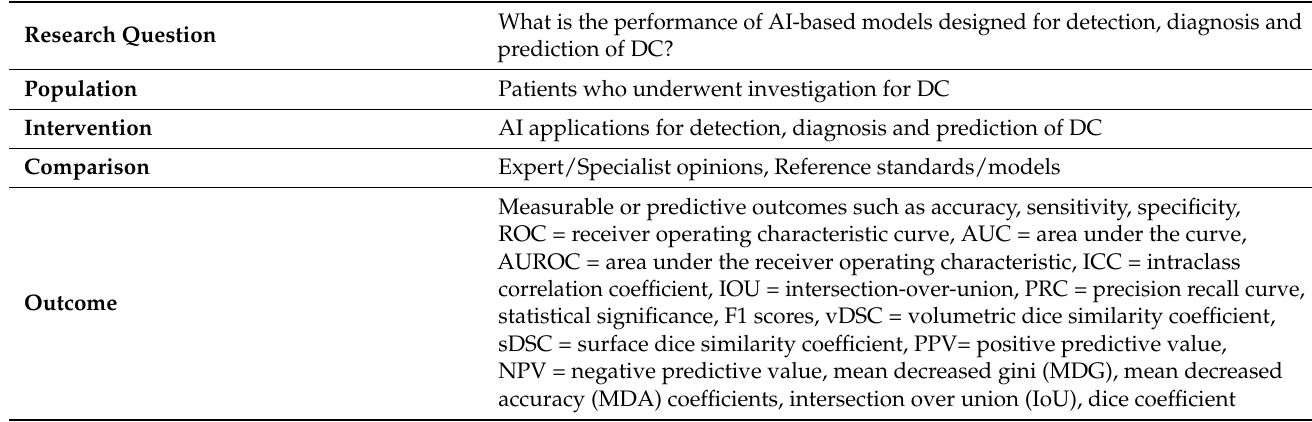
Table 1. Description of the PICO (P = Population, I = Intervention, C = Comparison, O = Outcome) elements. What is the performance of AI-based models designed for detection, diagnosis and Research Question prediction of